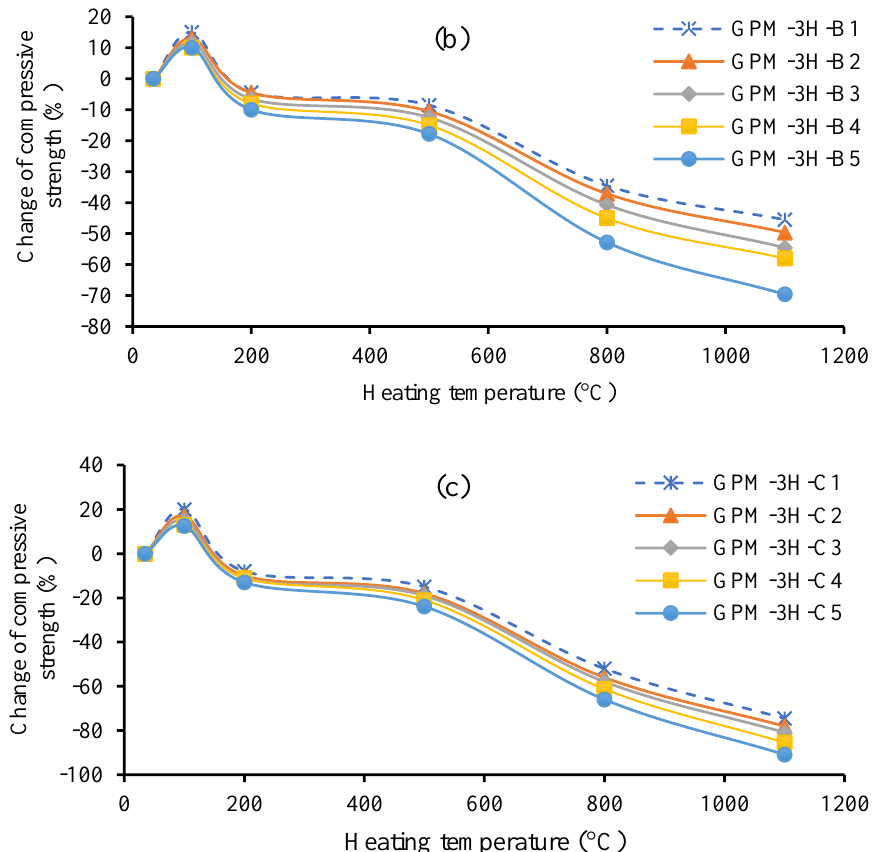
Figure 23. Change in compressive strength (%) vs. elevated temperature for the geopolymer material using various Na 2 SiO 3 -to-NaOH and FA-to-GGBS ratios with sand preheated at 110 ◦ C: ( a ) Series A geopolymer paste; ( b ) Series B geopolymer paste; ( c ) Series C geopolymer paste.